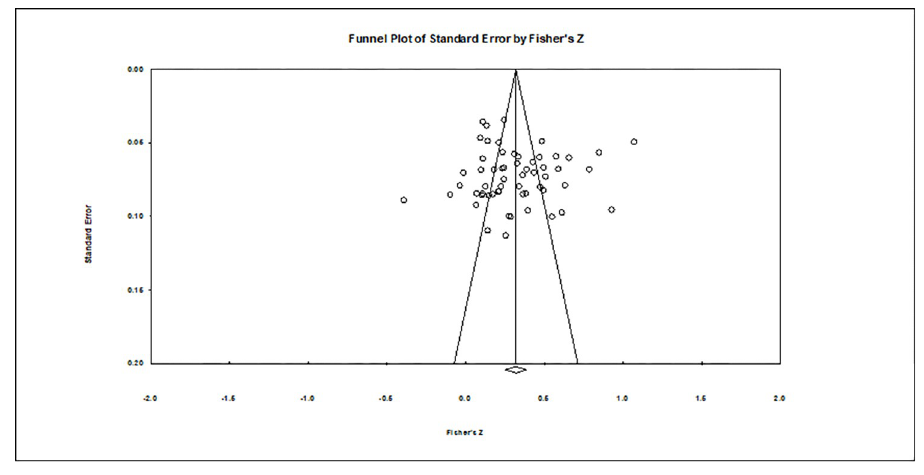
Fig 3. Funnel chart.